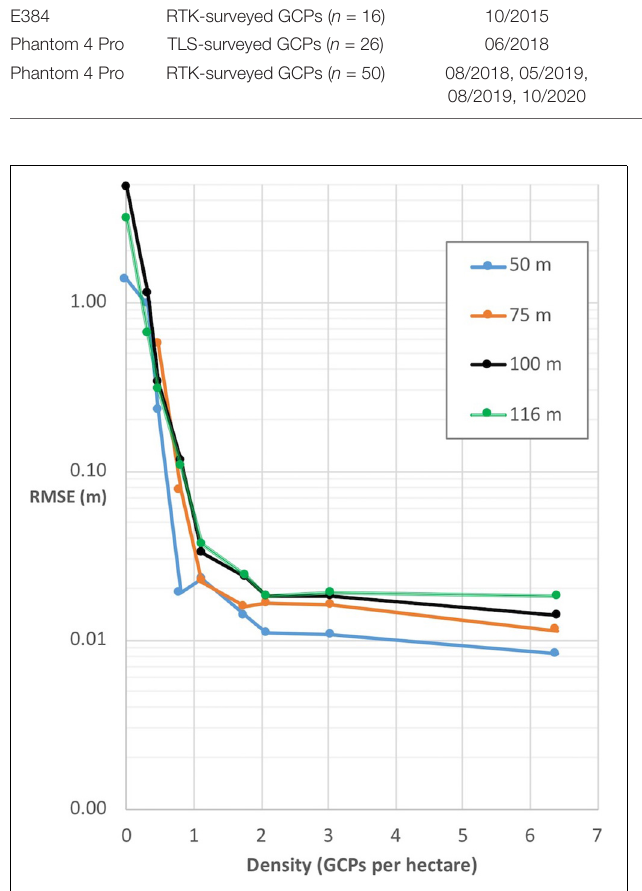
FIGURE 2 | Relationship between vertical DEM error (measured as RMSE) and GCP density, plotted for data collected at four different flight